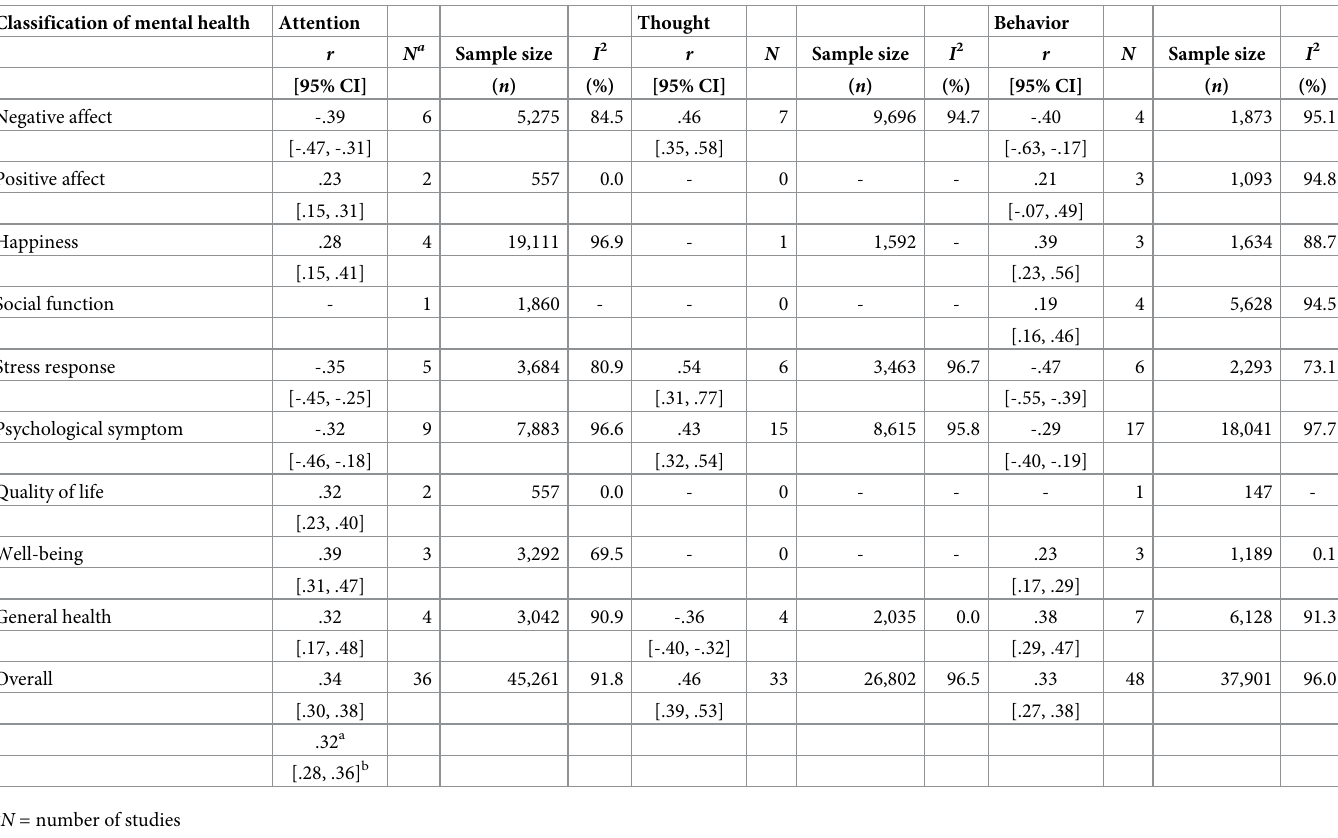
Table 4. Estimated associations between cognitive behavioral variables and mental health. Classification of mental